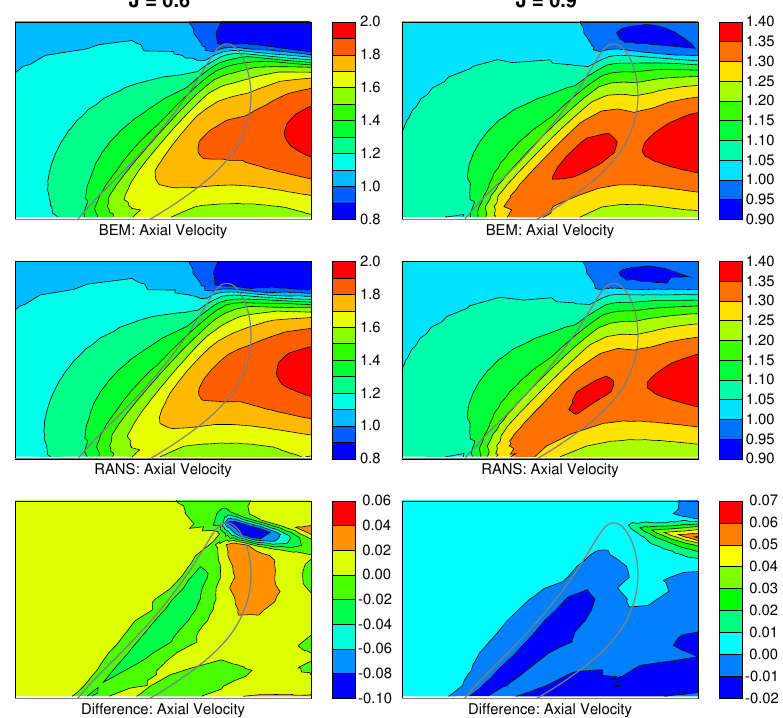
Figure 4. RANS and BEM axial velocity fields for DTMB P4384 at J = 0.6 and 0.9. The velocities are normalized using the inflow speed V